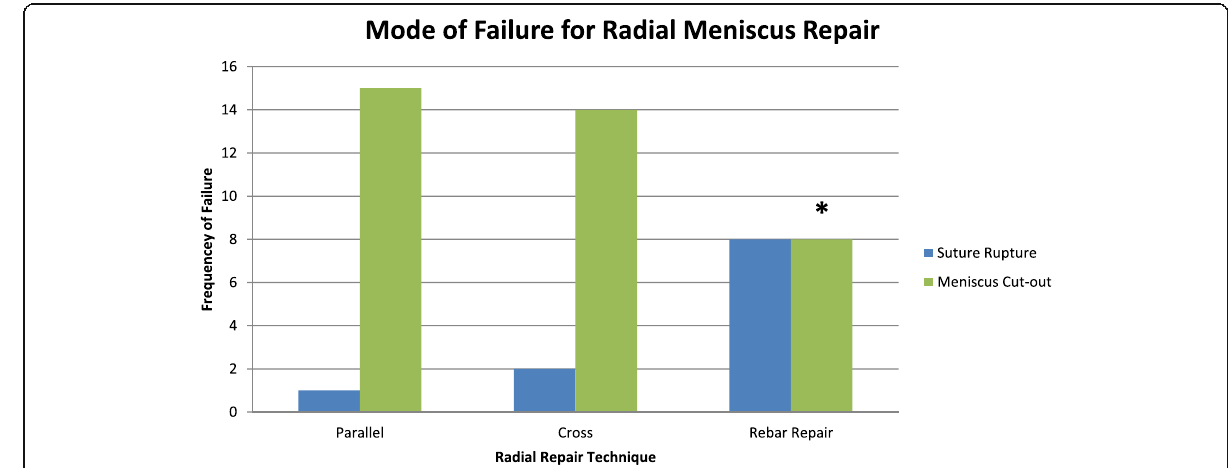
Fig. 5 Bar graph of the different modes of failure. * There was less meniscus suture cutout in the Rebar Repair group compared to the parallel and cross-stitch groups ( p < 0.01). The predominate mode of failure in the cross-stitch group and parallel repair group was meniscus suture cutout. There were 8 failures due to suture rupture and 8 due to meniscus suture cutout in the Rebar Repair